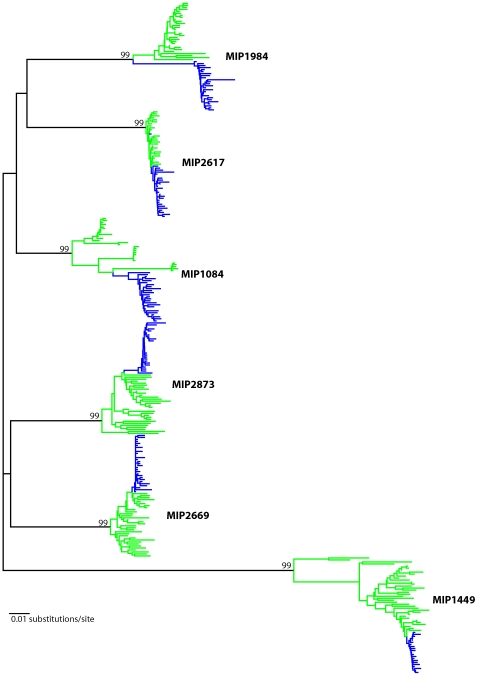
Neighbor-joining phylogenetic tree showing V1-V5 envelope gene sequences from all patients of the cohort with bootstrap values calculated from 1000 bootstrap replicates shown for each major branch.Each transmission pair is labeled with nucleotide sequences from mothers (green) and infants (blue). The tree was constructed using MEGA version 4.